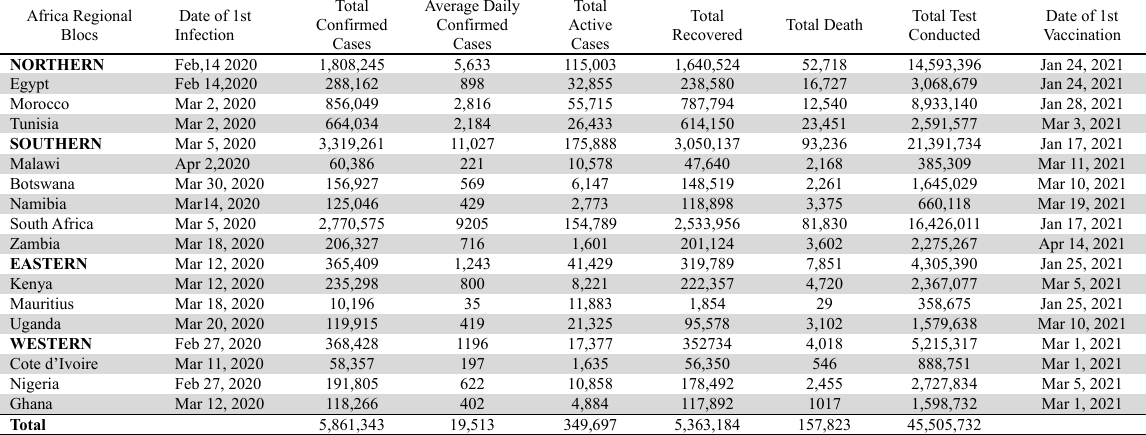
Situation of COVID-19 in the four regional blocs of Africa Africa Regional